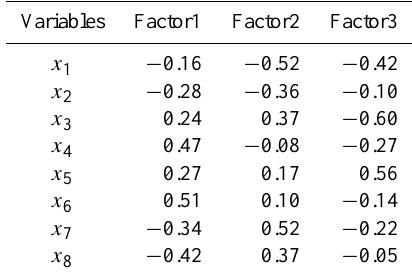
Table 5. Eigenvectors of principal